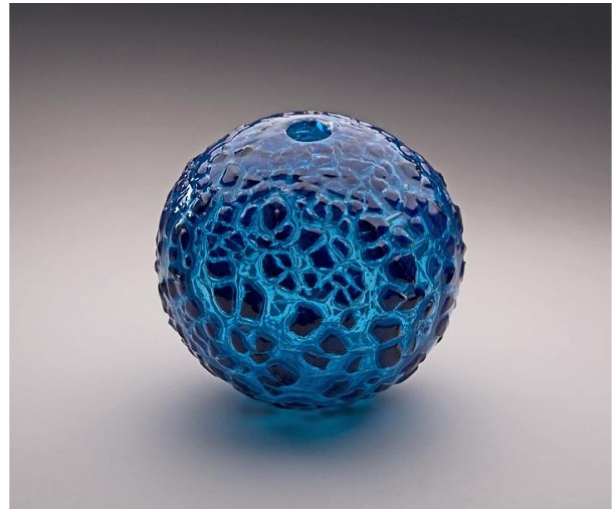
Figure 11. John Groth, blown glass, rolled up with ceramic, 2012. Courtesy of the artist.